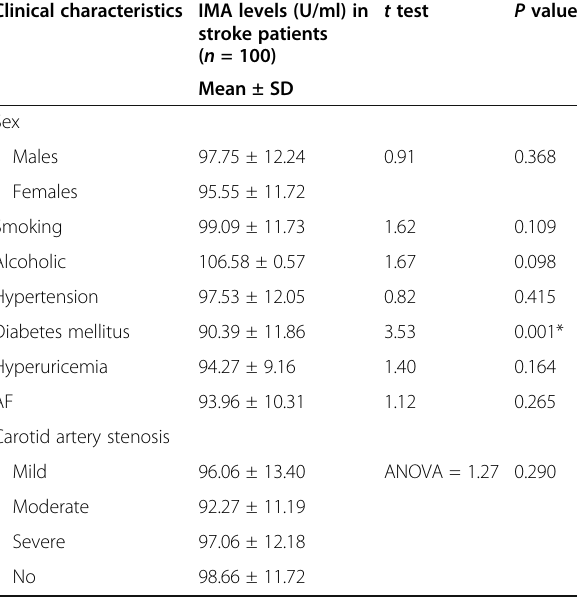
Table 8 Correlation between biomarker levels with volume of lesion in ischemic stroke and ICH and SAH severity